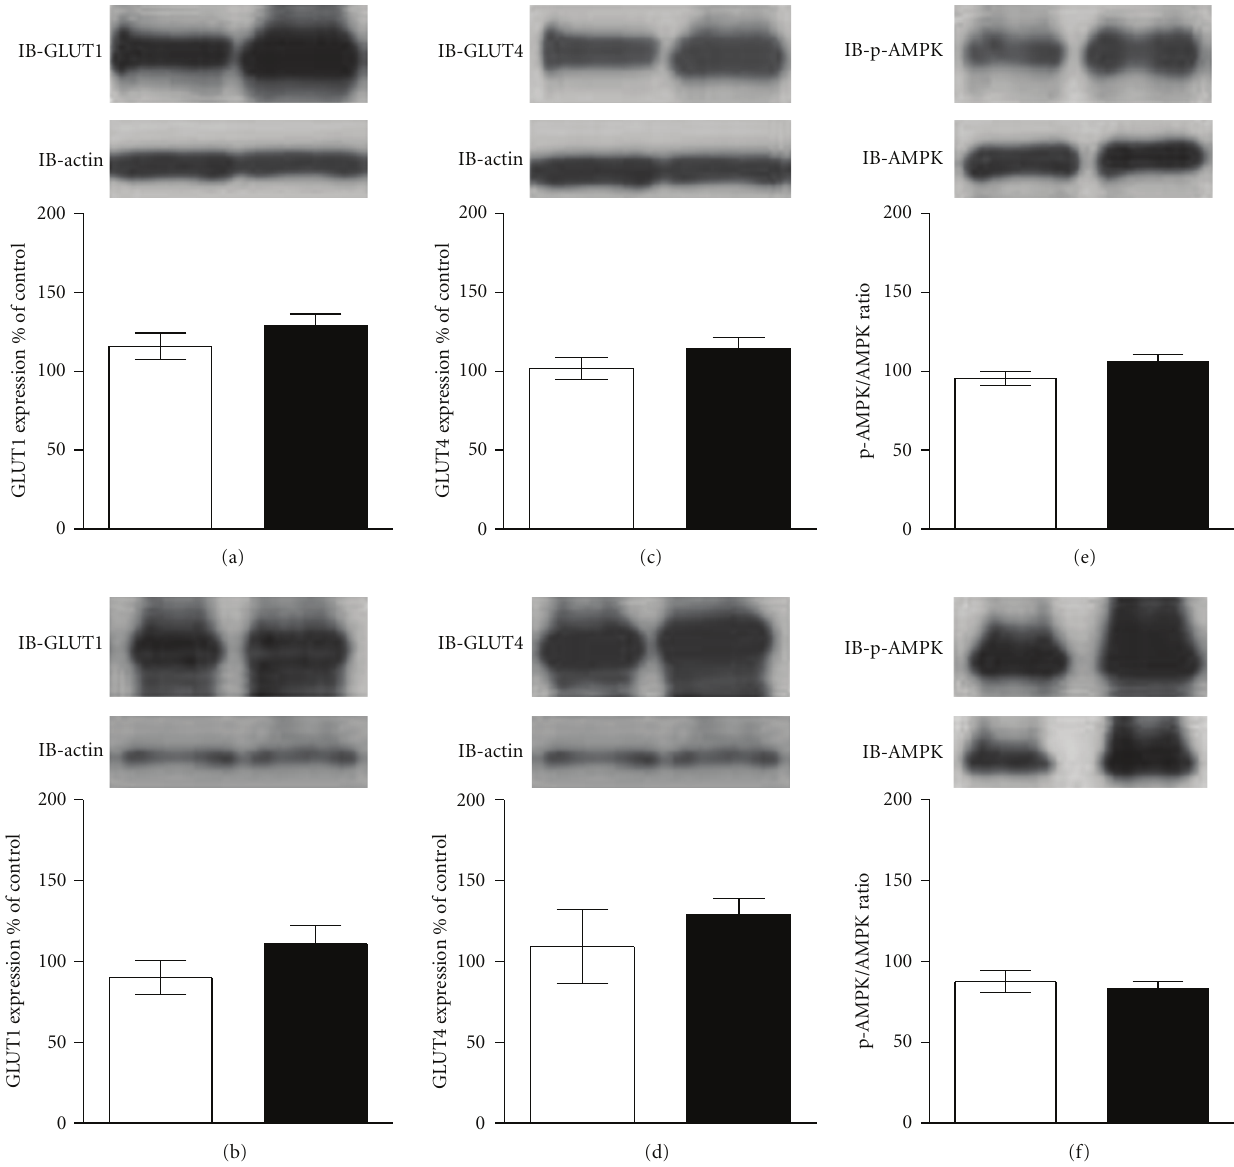
Figure 3: Western blotting analysis of GLUT1 and GLUT4 contents, and the pAMPK/AMPK ratio of (a, c, e) lymphocytes and (b, d, f) cardiomyocytes obtained from control group (white bars) and 24 h-fasted group (black bars). Graphics show the relative density of proteins levels which were normalized to those of Actin. Values represent mean ± SEM. Statistical analysis was calculated by Student’s t